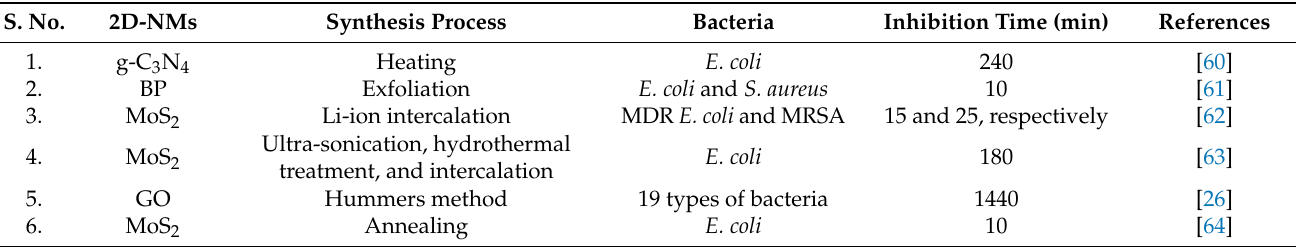
Table 1. Different 2D-NMs and their photo-antibacterial